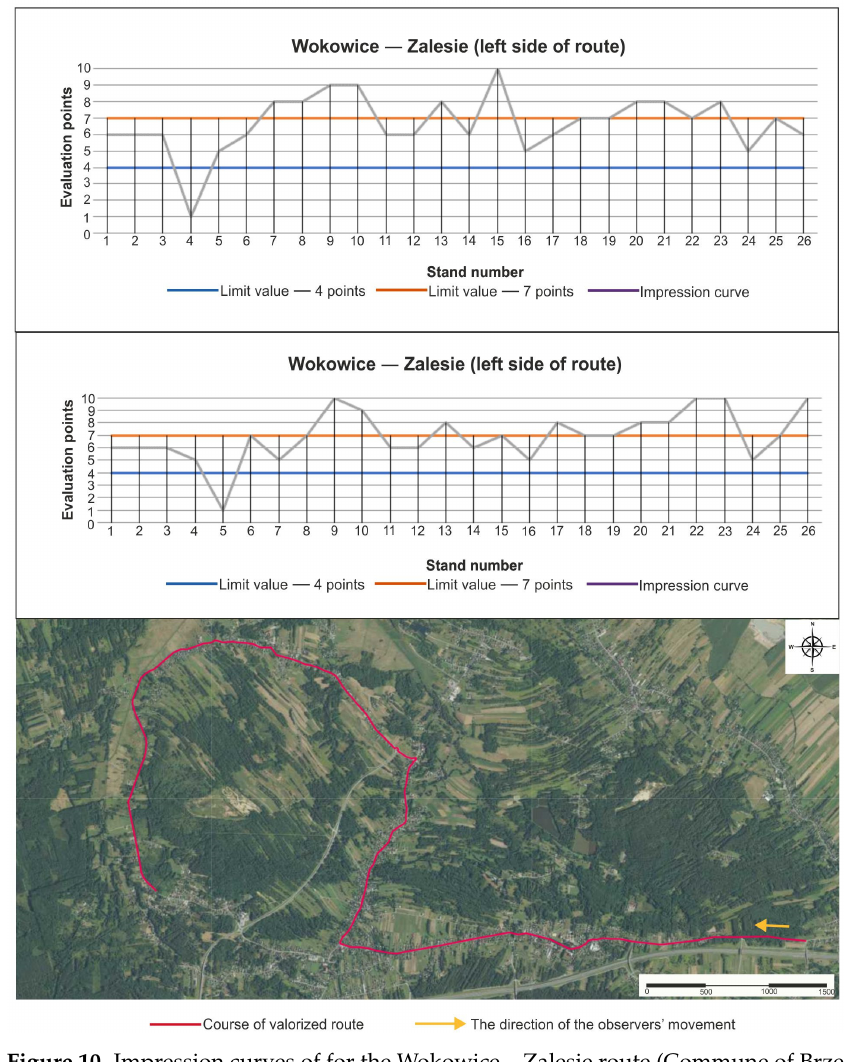
Figure 10. Impression curves of for the Wokowice—Zalesie route (Commune of Brzesko).